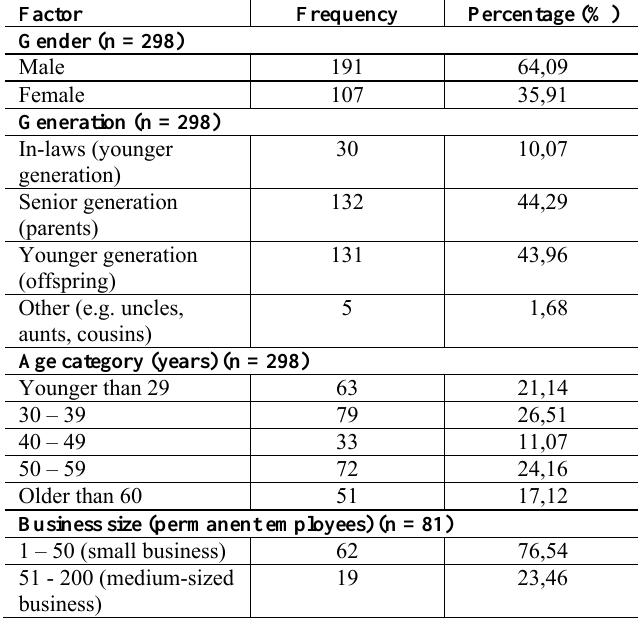
Table 1: Demographic information of the